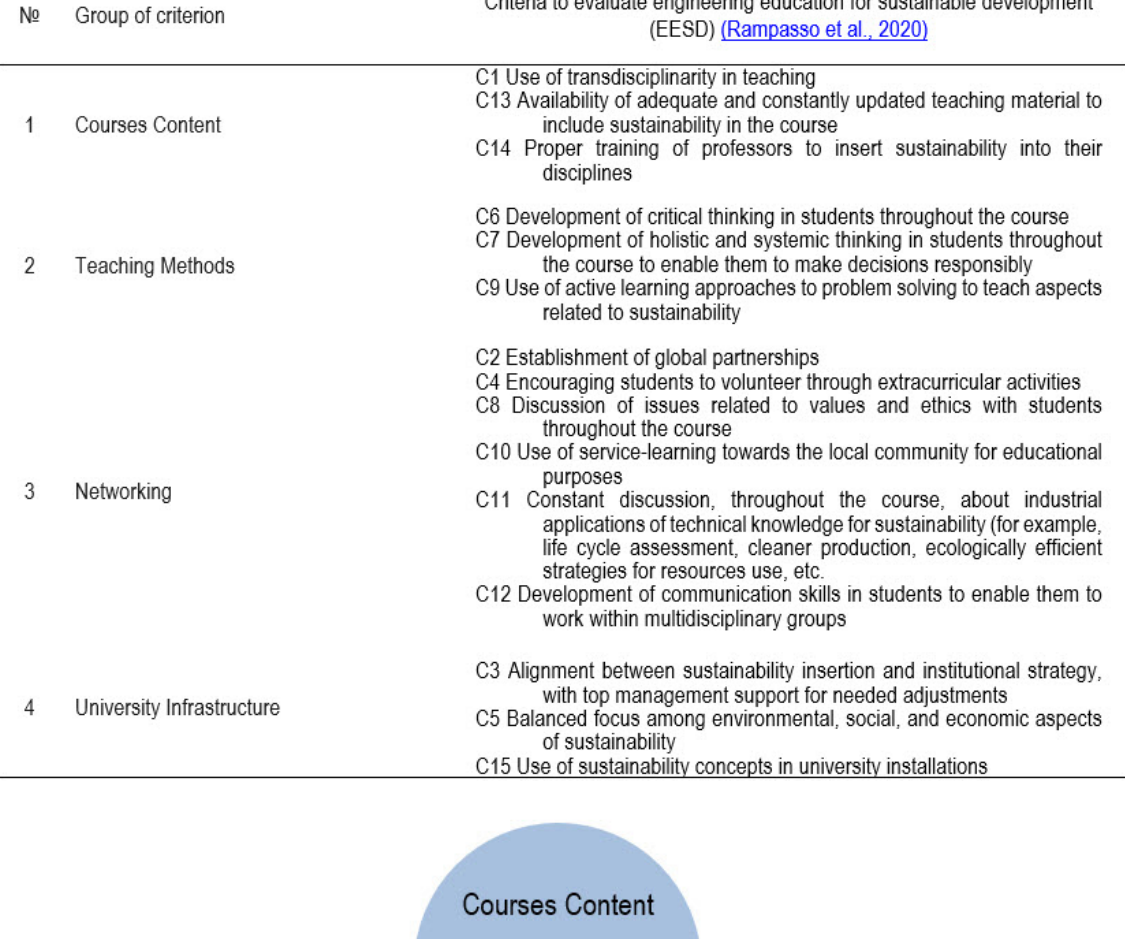
Criteria for the evaluation of engineering university education for sustainable development (EESD)